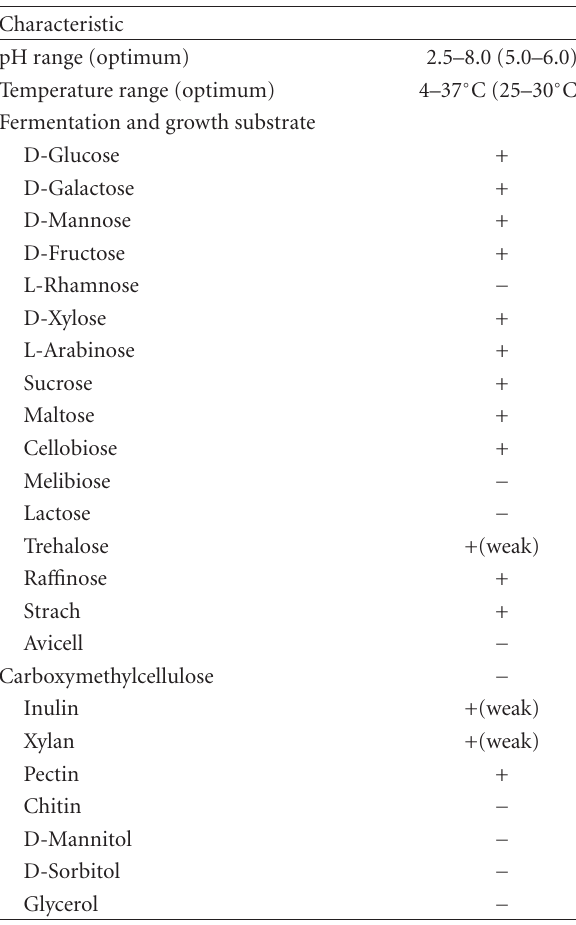
Table 1: Physiological and biochemical properties of RB-1. Characteristic